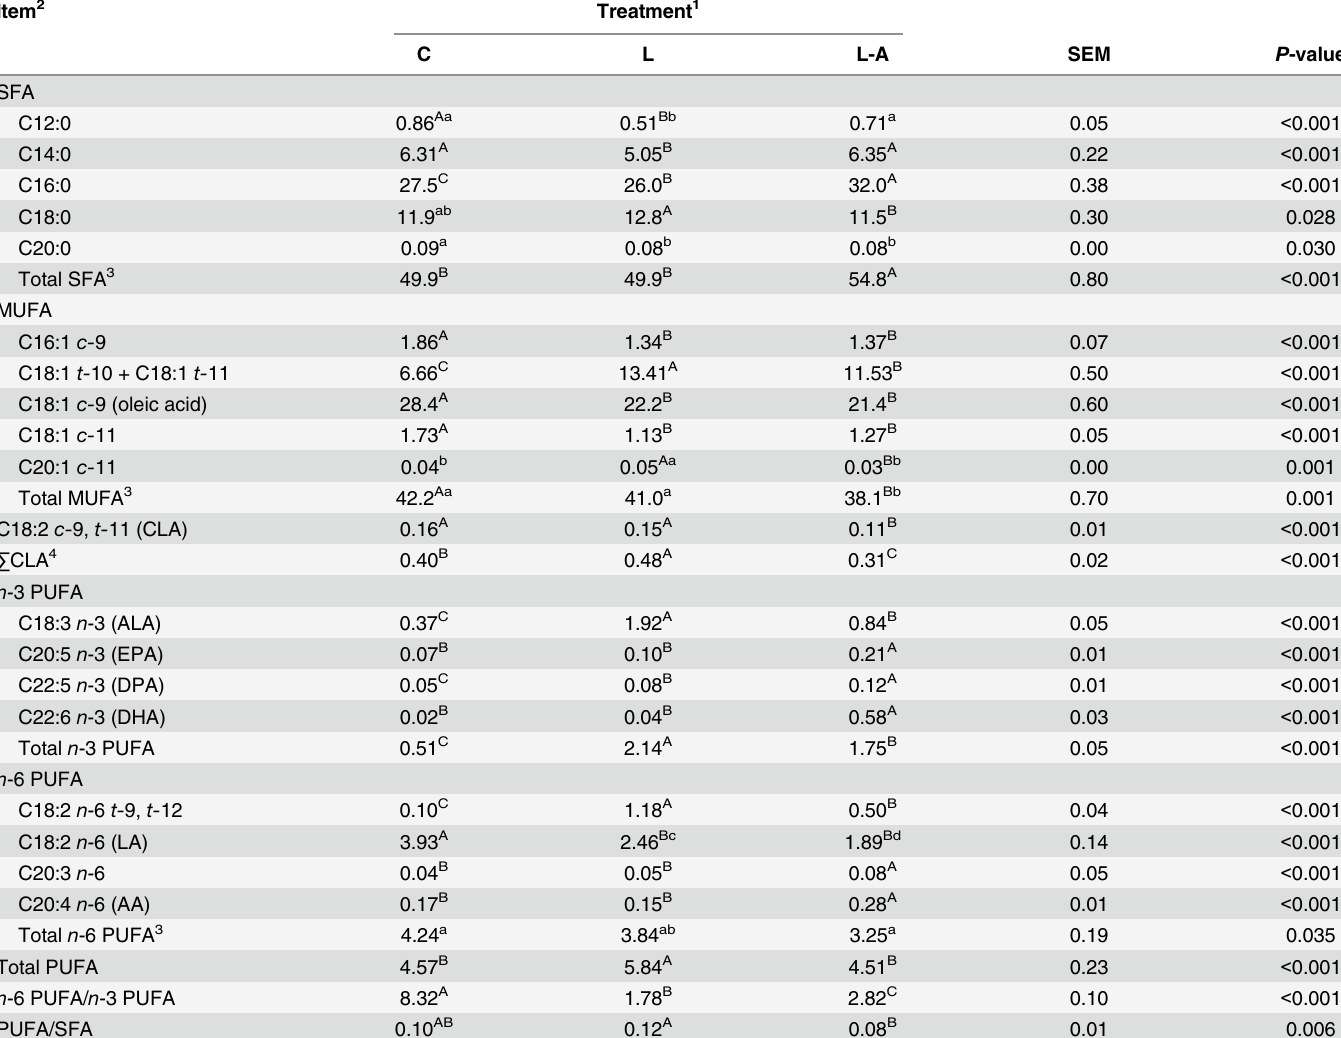
Table 4. Effects of addition of linseed or linseed and marine algae to the diet on fatty acid composition (g/100 g of total identified fatty acid methyl esters) in subcutaneous adipose tissue of Navarra breed